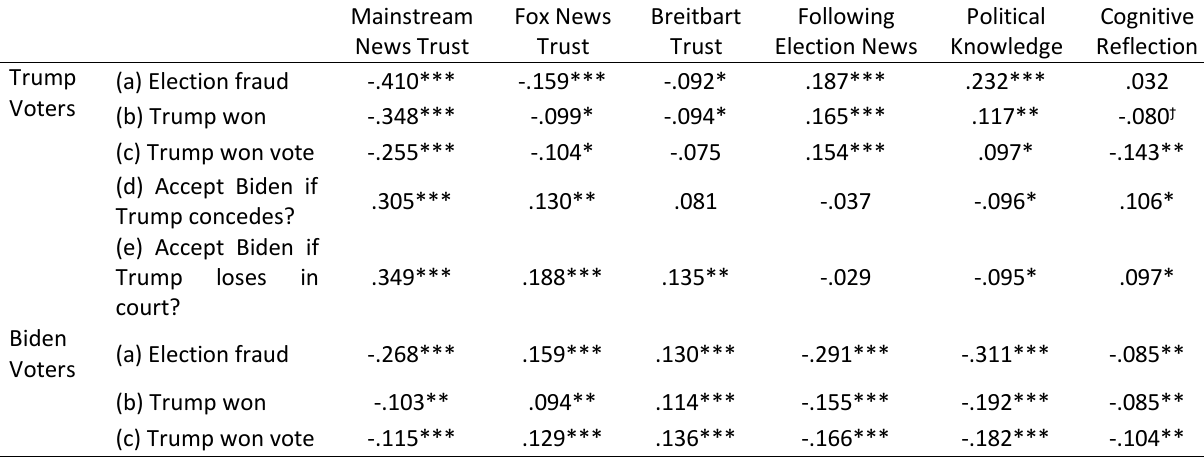
Table 1. Correlations among major